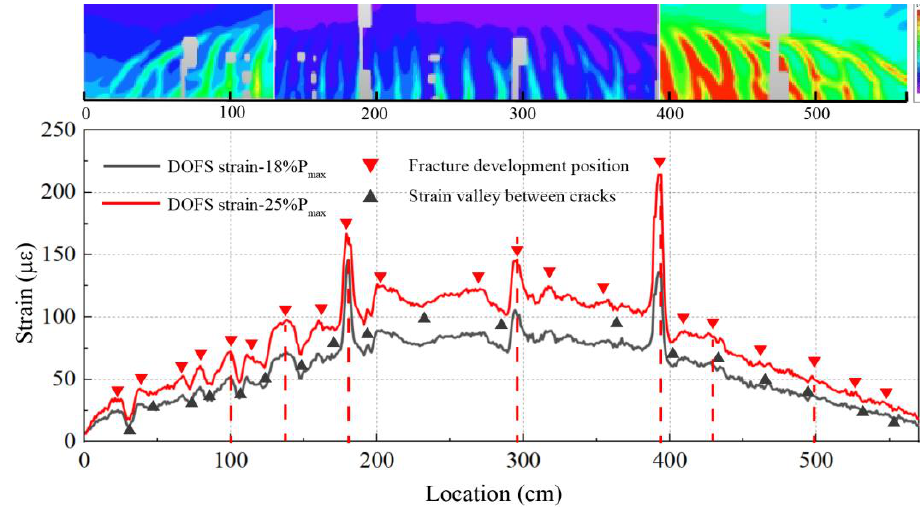
Figure 8. Crack location determined from the DFOS strain profile and compared to DIC measured strain field at